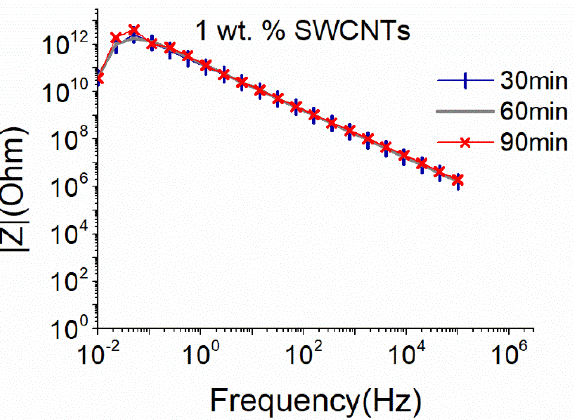
Figure 3. EIS plots of aqueous dispersion with 1 wt.% SWCNTs, using the small sonication probe at an amplitude of 50% (17.9 W).